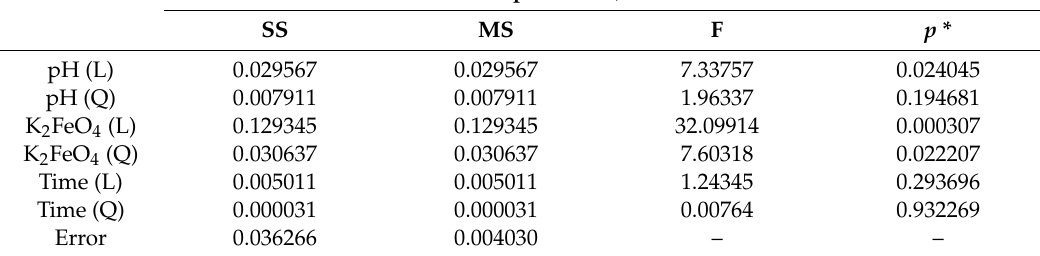
Table 4. Analysis of the CCD / RSM experiment using Statistica 13—verification of the adequacy of the model using